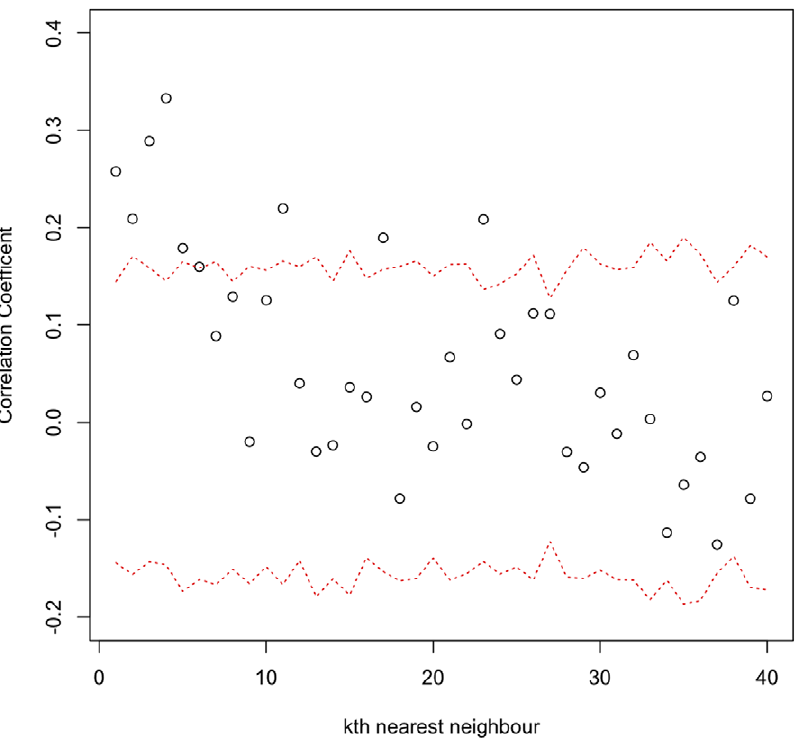
Figure 7. Mean correlation of the estimated years since last PI between herds and their K th nearest neighbour and the 95% range (red dotted lines) from 1000 randomly allocated permutations.